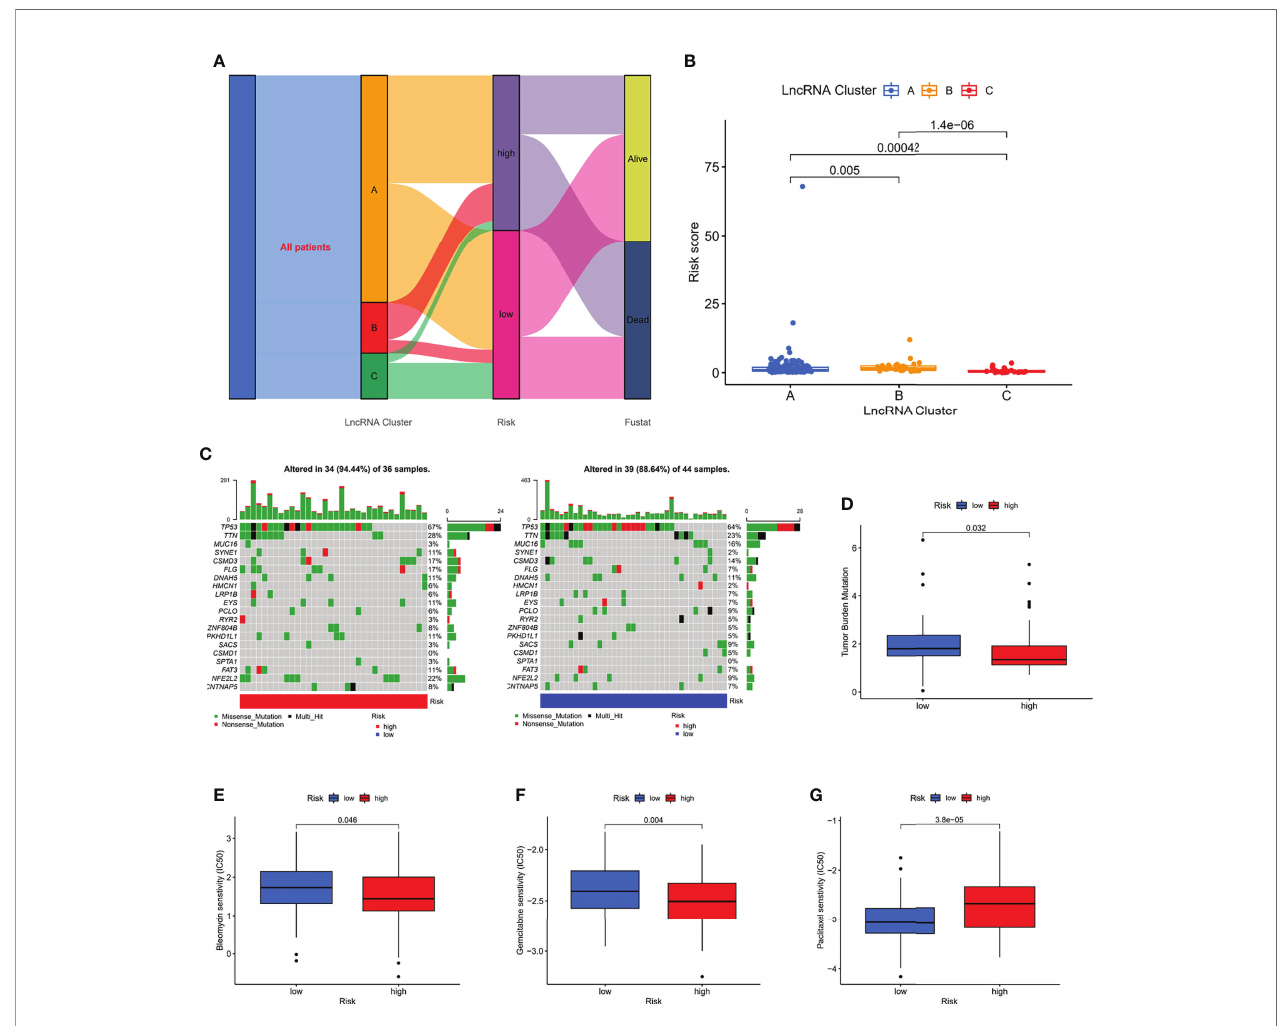
FIGURE 8 | Correlation of risk score with molecular clusters, gene mutations, and chemotherapy sensitivity. (A) The sankey diagram of the relationship among the clusters, risk score and survival state. (B) Risk score levels of A/B/C clusters. (C, D) The waterfall plot of somatic mutation features in different risk subgroups. (E – G) The boxplot of Sensitivity of bleomycin, gemcitabine, paclitaxel in patients with high-risk subgroup and low-risk